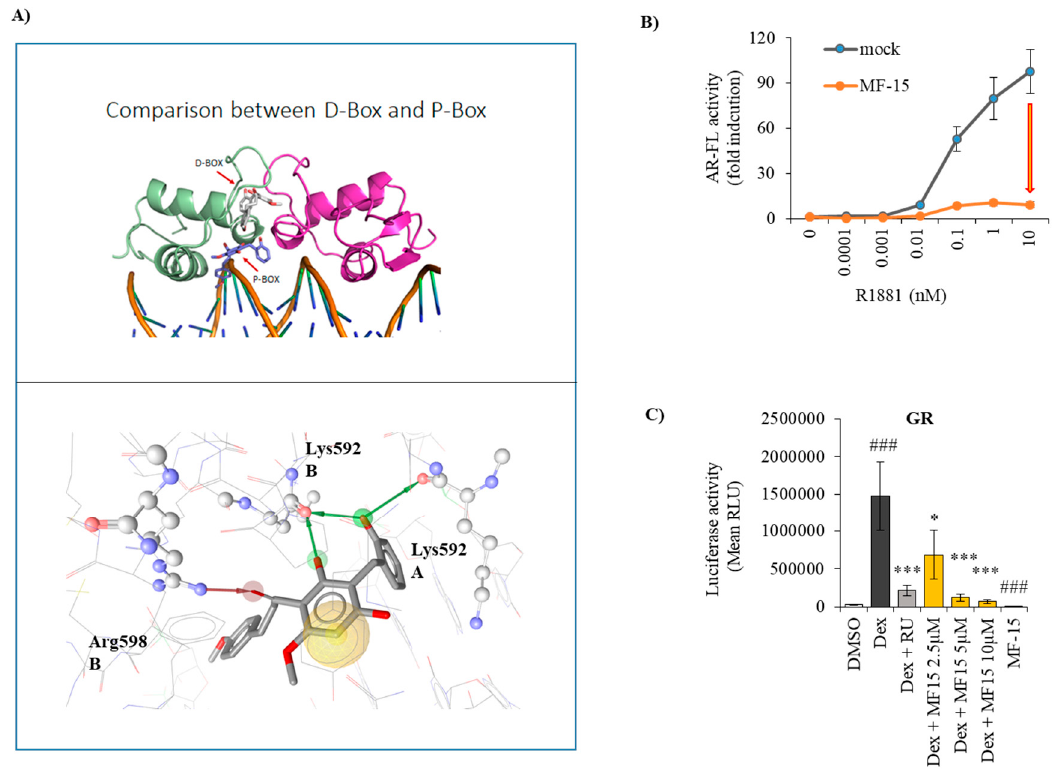
Figure 6. MF-15 targets within the AR-DBD. ( A ) Upper image: Docking poses of MF-15 in the D-box (white) and the P-box of the AR-DBD (blue). The A chain of AR is shown in green and the B chain in magenta. Lower image: Interactions of MF-15 within the P-box binding site. Green arrows signify hydrogen bond donor interactions with Lys592 (from the A and B chain), the red arrow marks a hydrogen bond acceptor interaction with Arg598. The yellow sphere represents hydrophobic contacts between ligand and binding pocket. ( B ) PC-3 cells were transiently transfected with AR-FL and incubated with increasing concentrations of R1881 without (blue curve) or with 10 µM MF-15 (orange curve) in the reporter gene assay described before. Data represent the mean ±SEM from three independent experiments. ( C ). PC-3 cells were transiently transfected with GR under the control of a ARE2TATA promoter and seeded into 96-well plates in RPMI + 2% FCS supplemented with 10 µM MF-15 alone or with increasing concentrations of MF-15 or 5 µM mifepristone (RU) and 1 nM of dexamethasone (Dex). Luciferase reporter gene activity was determined with Nano Glow Dual Assay (Promega) by measuring absorbance on a CYTATION multiplate reader instrument. Data represent the mean ±SEM from three independent experiments. Statistical comparisons to the mock control were expressed in the graph with a hash key (### p < 0.001) comparisons to R1881 with an asterisk (*) (* p < 0.05, *** p < 0.001).